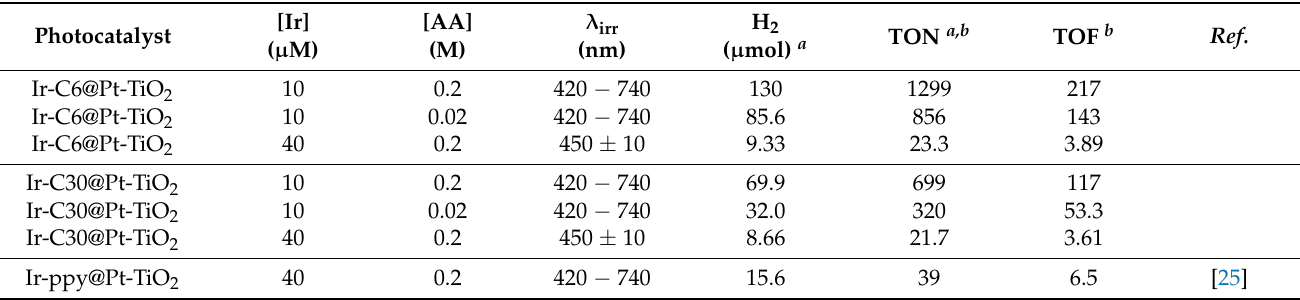
Table 3. Results of the photocatalytic H 2 evolution reactions in the presence of L -ascorbic acid (AA).